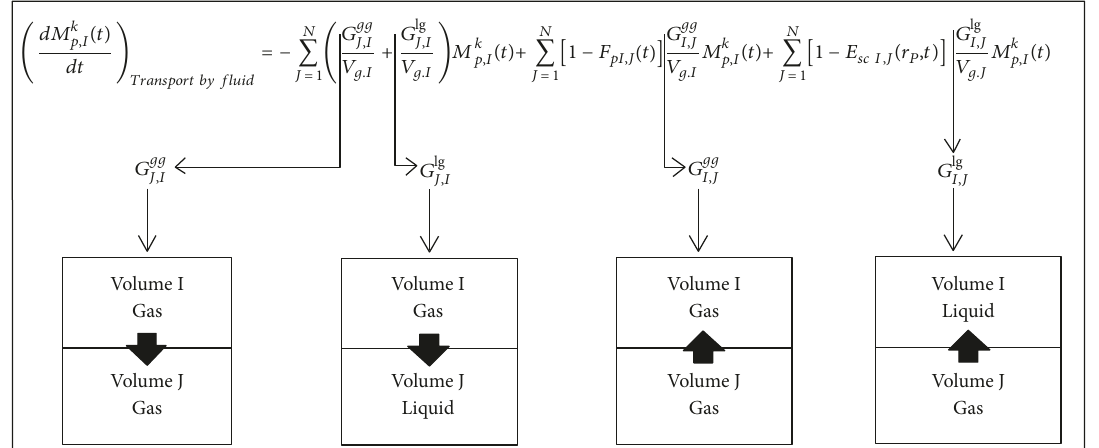
Figure 4: Aerosol transportation calculation scheme of ART Mod